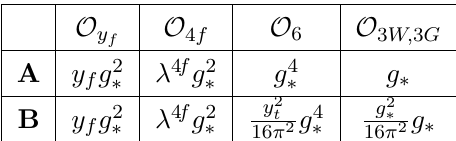
Table 3 . Operators that can be basically divided in two classes of scalings, i.e., A : ALH-like and B : SILH-like. See text for